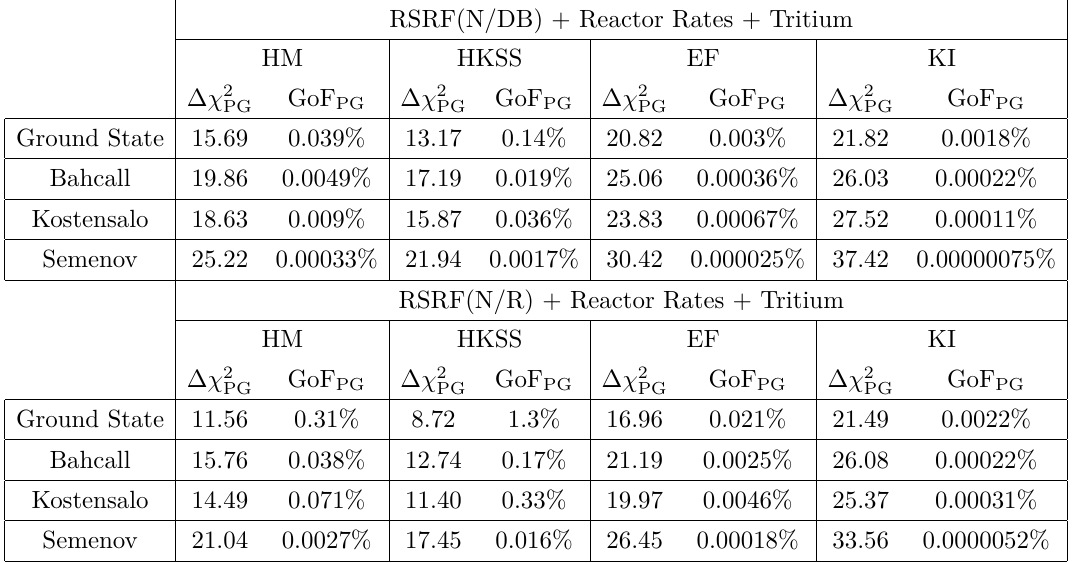
Table 5. χ 2 difference ∆ χ 2 of the parameter goodness of fit test [36] applied to the comparison PG of the neutrino oscillation fits of the reactor rates, spectral ratio data, and tritium data with the Gallium data using the four Gallium detection cross sections in table 1. The values of the corre- sponding parameter goodness of fit GoF PG are calculated with two degrees of freedom corresponding to the two common oscillation parameters sin 2 2 ϑ ee and ∆ m 2 . The column titles RSRF(N/DB) 41 and RSRF(N/R) indicate, respectively, the combined fits of NEOS/Daya Bay and NEOS/RENO data with those of the other reactor spectral ratio experiments discussed in the text (DANSS, PROSPECT, STEREO, and Bugey-3). The column titles HM, HKSS, EF, and KI refer to the four reactor neutrino fluxes discussed in section